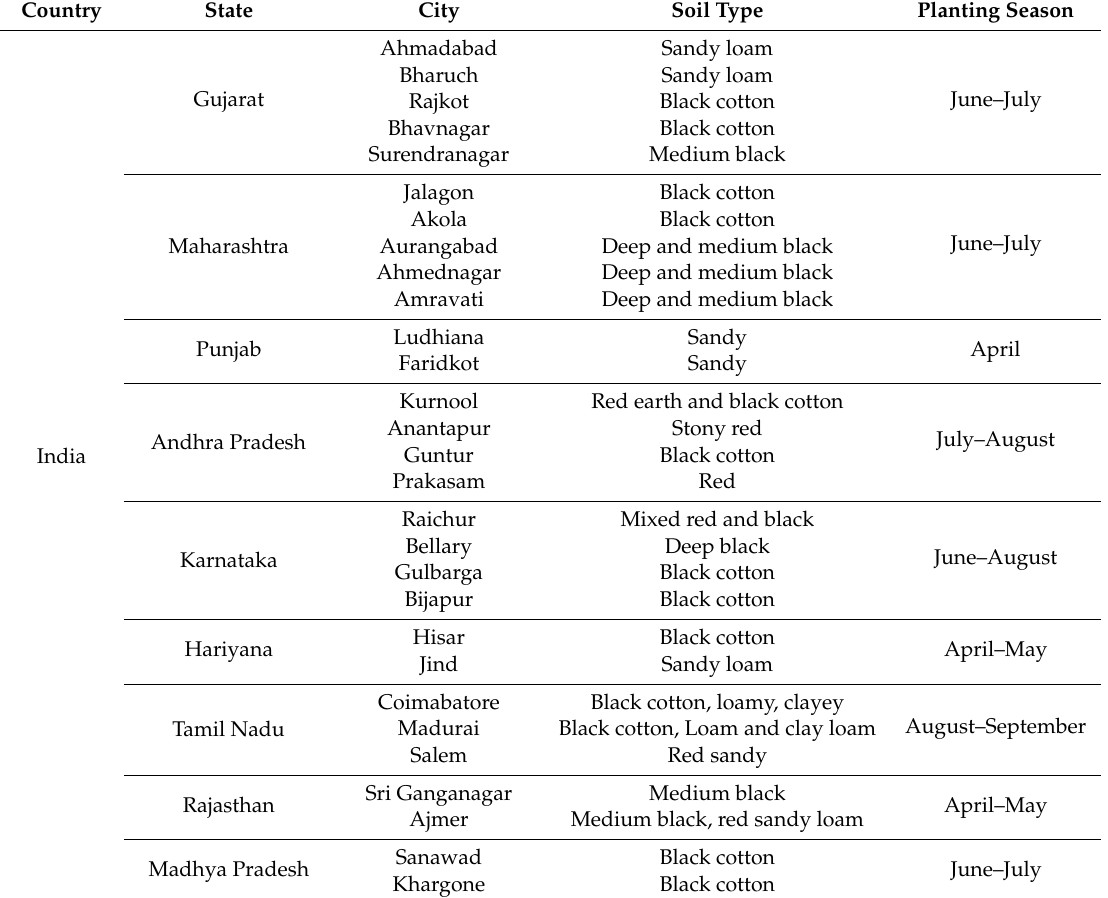
Table A10. Soil type and cotton planting season of di ff erent states of India [92–121]. Country